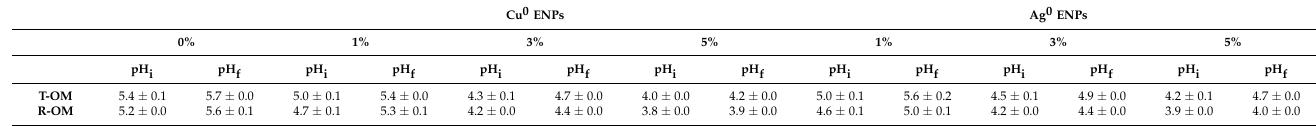
Table 4. pH changes associated to H 2 PO 4 − adsorption in the absence and presence of different doses of Cu 0 or Ag 0 ENPs and two levels of soil organic matter content (total organic matter, T-OM and partial removal of organic matter, R-OM). Experimental conditions: 6.47 mmol · L − 1 H 2 PO 4 − solution at pH 5.5, 0.01 M KCl at 20 ± 2 ◦ C. Initial pH (pH i ) and final pH (pH f ) were measured after H 2 PO 4 − solution added to soil samples (time 0 min) and after H 2 PO 4 − adsorption (1440 min), respectively.